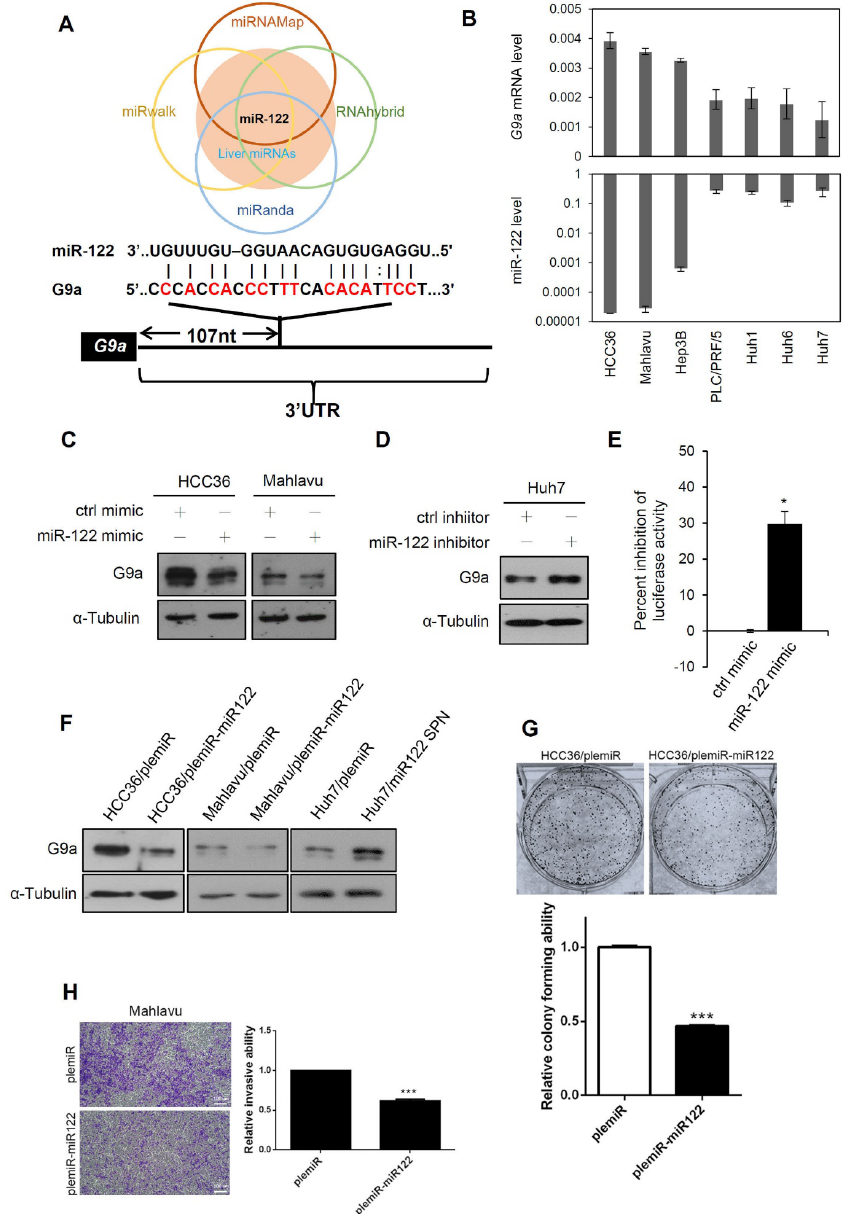
Figure 5. Liver-specific miR-122 regulates G9a expression, and the growth and motility of hepatocellular carcinoma (HCC) cells. ( A ) Upper panel: Venn diagram of candidate miRNAs that possibly target G9a. G9a-targeting miRNAs predicted from miRwalk, miRanda, RNAhybrid, and miRNAMap were compared and further merged with liver-enriched miRNAs. Lower panel: Predicted binding sites between the 3 (cid:48) -untranslated region (UTR) of G9a and miR-122 are presented. ( B ) Expression levels (2 − ∆ Ct ) of G9a mRNA and miR-122 were determined by an RT-qPCR. miR-122 levels are shown on a log scale. ( C ) Expression levels of G9a were determined by immunoblotting in HCC36 and Mahlavu cells transfected with a control or miR-122 mimic. ( D ) Immunoblot analysis of G9a in Huh7 cells which were transfected with the control or miR-122 inhibitor. ( E ) G9a luciferase 3 (cid:48) UTR reporter vector was transfected with the control mimic or miR-122 mimic into 293T cells. Luciferase activities were measured, and results are shown as the percent inhibition of the control. ( F ) HCC cells with stable ectopic expression of either miR-122 or miR-122 sponge were analyzed for G9a expression via an immunoblot analysis. ( G , H ) HCC cells with stable ectopic expression of either miR-122 or control vector (plemiR) were analyzed for colony-forming ( G ) and invasive ( H ) abilities. Scale bar, 100 µ m.Three independent replicates were performed in each experiment. Data are presented as the mean ± SD. * p < 0.05, *** p < 0.001 versus the control group. α -Tubulin was used as a loading control. All uncropped immunoblotting images for this study are summarized in Figure